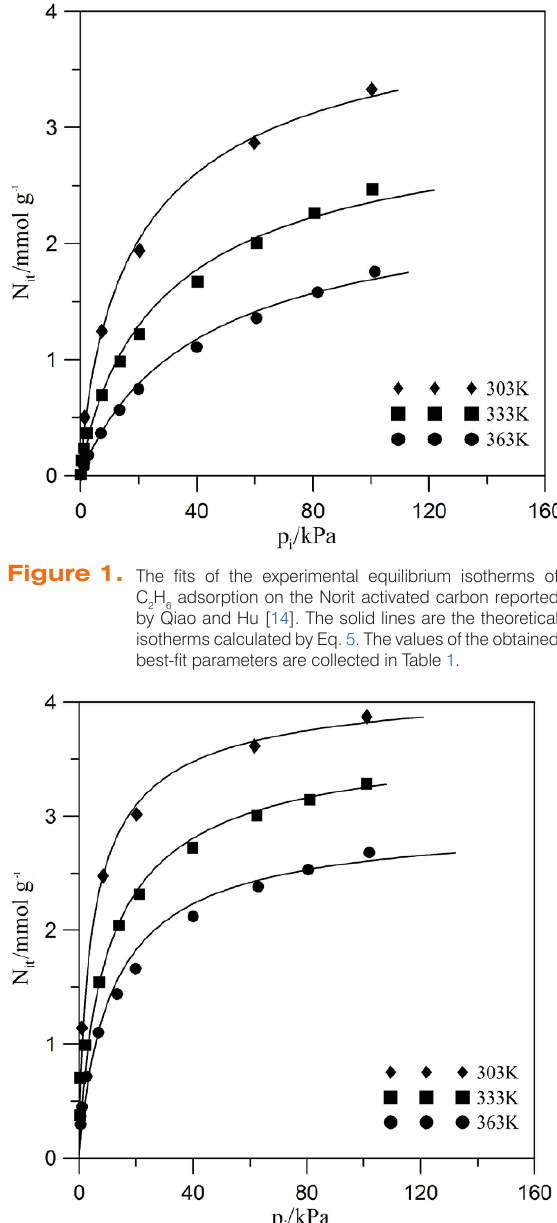
Figure 2. The fits of the experimental equilibrium isotherms of C H adsorption on the Norit activated carbon reported 3 8 by Qiao and Hu [14]. The solid lines are the theoretical isotherms calculated by Eq. 5. The values of the obtained best-fit parameters are collected in Table its increase with the growing number of CH mers in the 2 adsorbed species. At the same time the arrangement of the adsorbed molecules improves – the non- randomness parameter α increases. These results are in agreement with our previous studies [ 13] and indicate that propane molecules are distributed on the surface in a more ordered way than ethane.